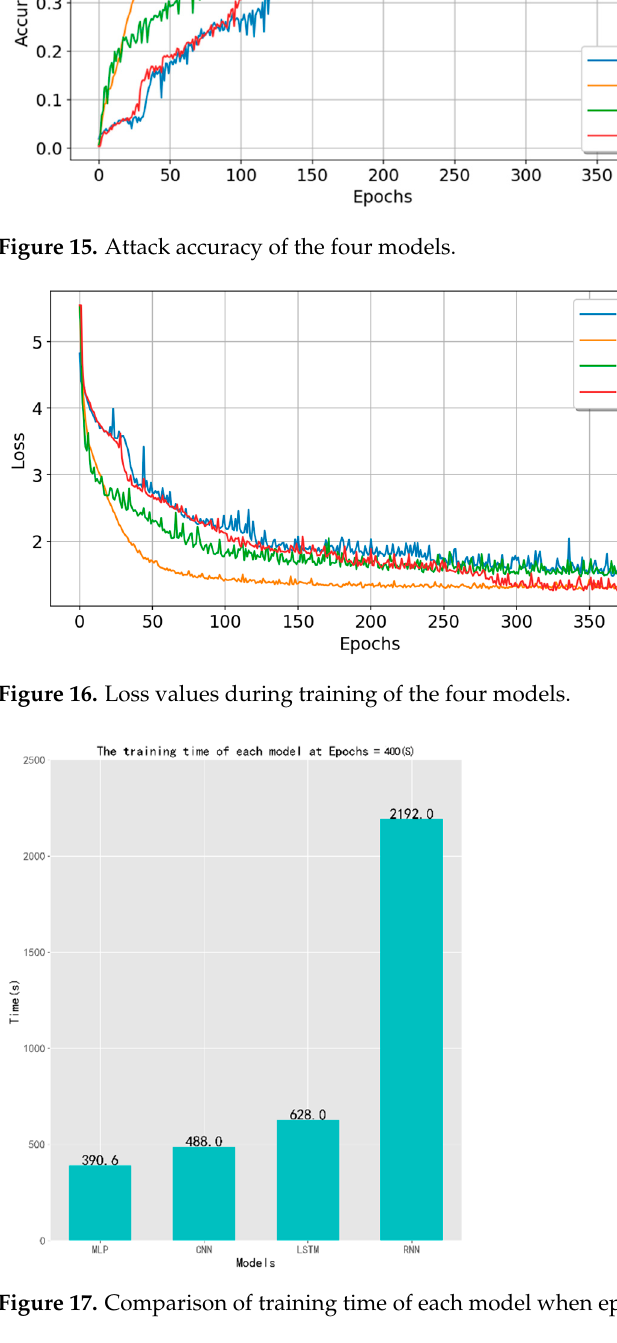
Figure 17. Comparison of training time of each model when epoch is 400.